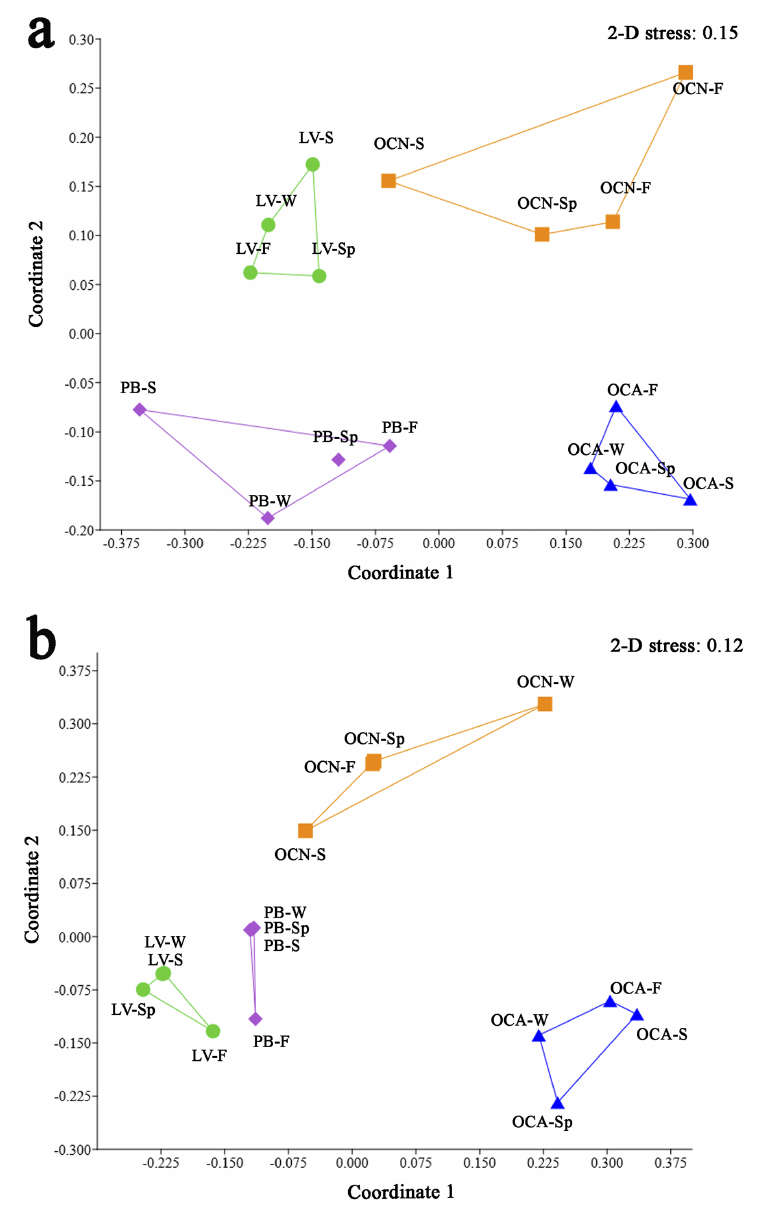
Figure 4. Non-Metric Multidimensional Scaling